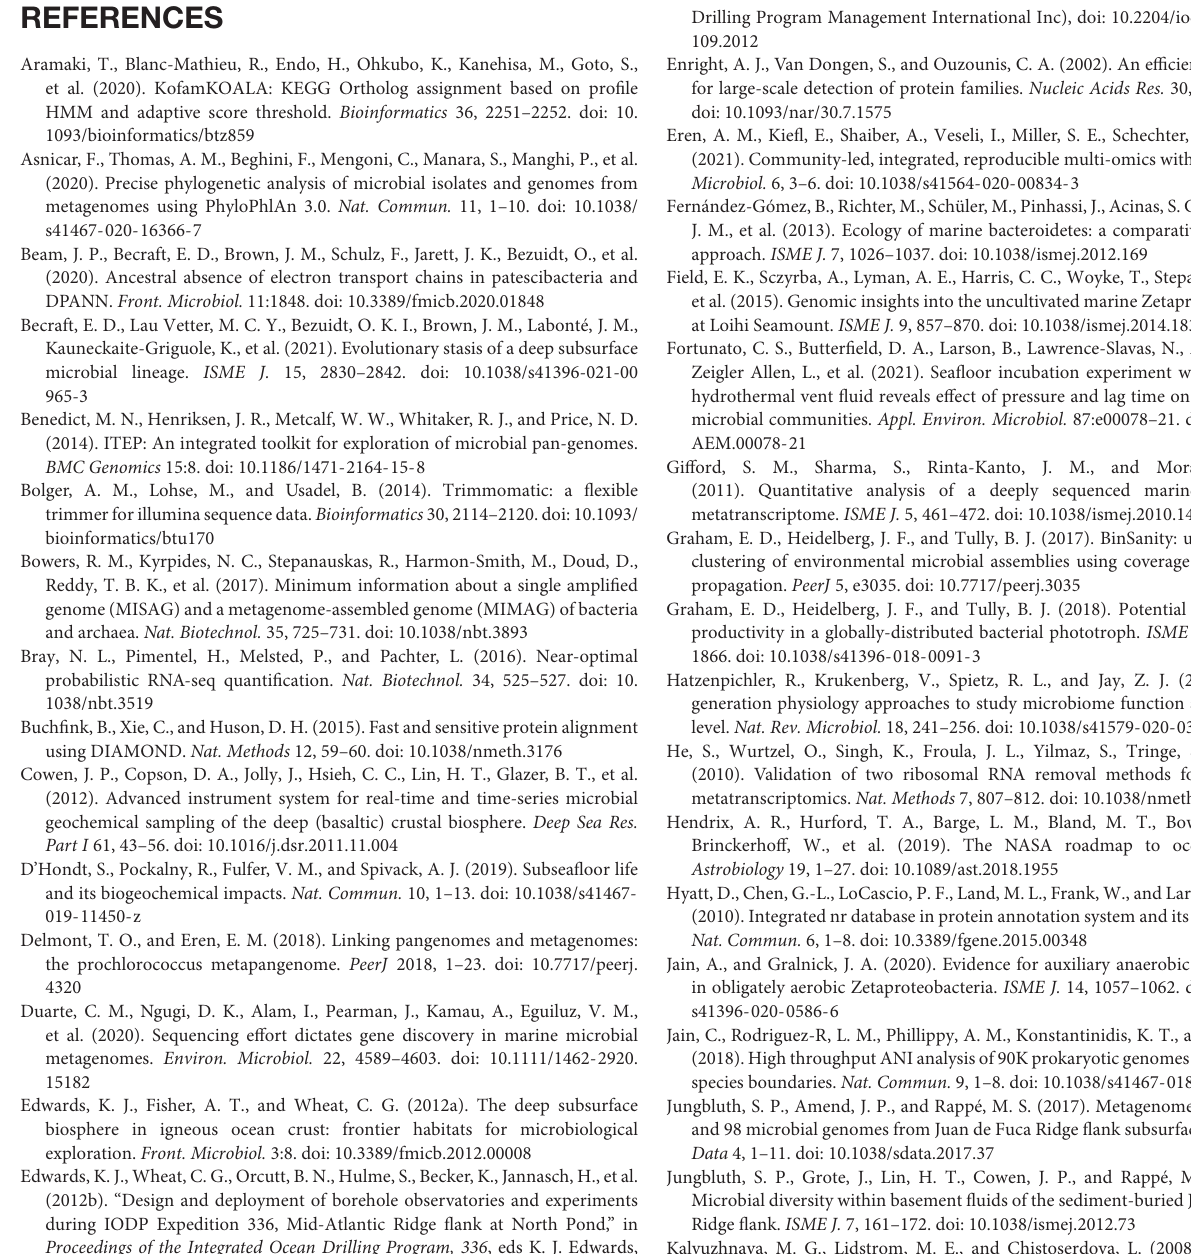
metagenomic read samples from Tully et al., 2018 (samples starting with NP12 and NP14) and Seyler et al. (2020) (samples starting in NP17 and metatranscriptomic samples ending in -RNA).